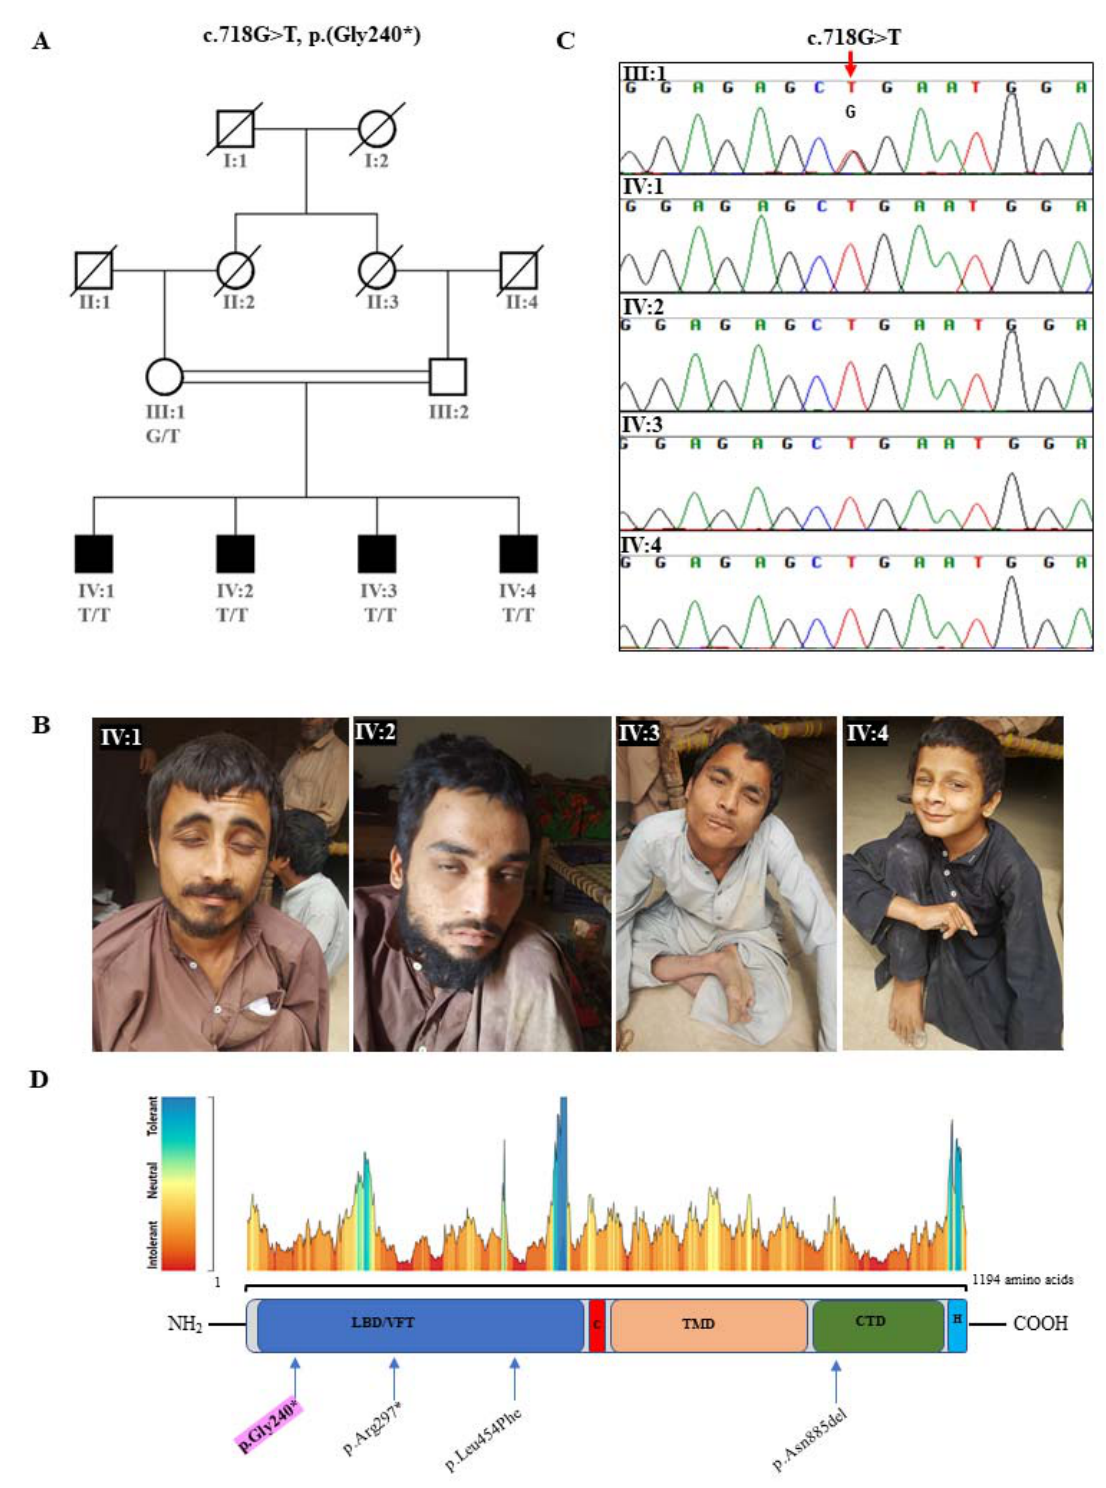
Figure 1. ( A ) Four-generation pedigree of the family showing four affected males (filled squares) born to first cousins. All affected individuals were homozygous (T/T) while the mother was carrier for the variant (G/T). ( B ) Representative images of four affected individuals (IV:1–4). ( C ) Chromatograms showing the GRM1: c.718G>T: p. (Gly240*) variant specified by red arrow on the top. ( D ) The domain structure of the 1194 amino acid mGluR1 α isoform obtained from [5,9,24–26] and the NCBI “Conserved domain search” tool. LBD/VFT: ligand-binding domain/Venus fly trap; C: cysteine-rich domain; TMD: heptaspanning transmembrane domain; CTD: C-terminal domain; H: Homer 1 binding